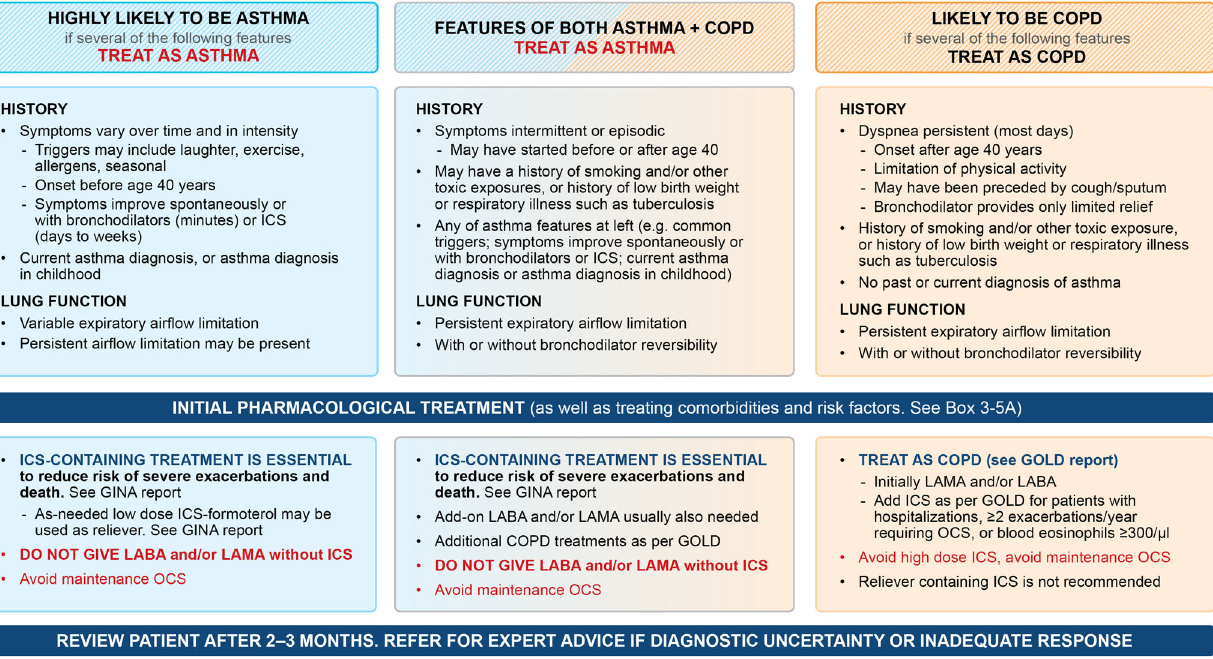
Fig. 3 Approach to initial treatment in patients with asthma and/or COPD. GOLD Global Initiative for Obstructive Lung Disease, ICS inhaled corticosteroid, LABA long-acting β 2 agonist; LAMA long-acting muscarinic antagonist. A summary of differentiating and diagnostic features in people with Asthma, COPD and Asthma + COPD. Source: Box 5 – 2 in GINA 2022. Reproduced with permission from ref. 11